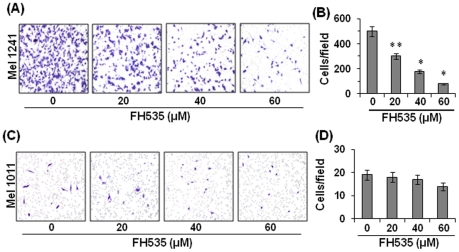
Effect of FH535, an inhibitor of β-catenin, on melanoma cell migration.(A) Mel 1241 cells were incubated with FH535 for 8 h and cell migration was determined using invasion assay. FH535 inhibits the cell migration of Mel 1241 cells in a dose-dependent manner. (B) The migratory cells were counted on the membrane under microscope and the results are expressed as the mean number of migratory cells ± SD per microscopic field. Significant inhibition versus control, *
P<0.001, **
P<0.01. (C) Treatment of Mel 1011 cells with FH535 for 8 h did not inhibit cell migration compared to non-FH535-treated control. (D) Migratory cells were counted under microscope and the results are expressed as the mean number of migratory cells± SD per microscopic field. Migration assays were repeated three times and representative pictures of cell migration are shown. No statistical significance of difference versus un-treated controls.